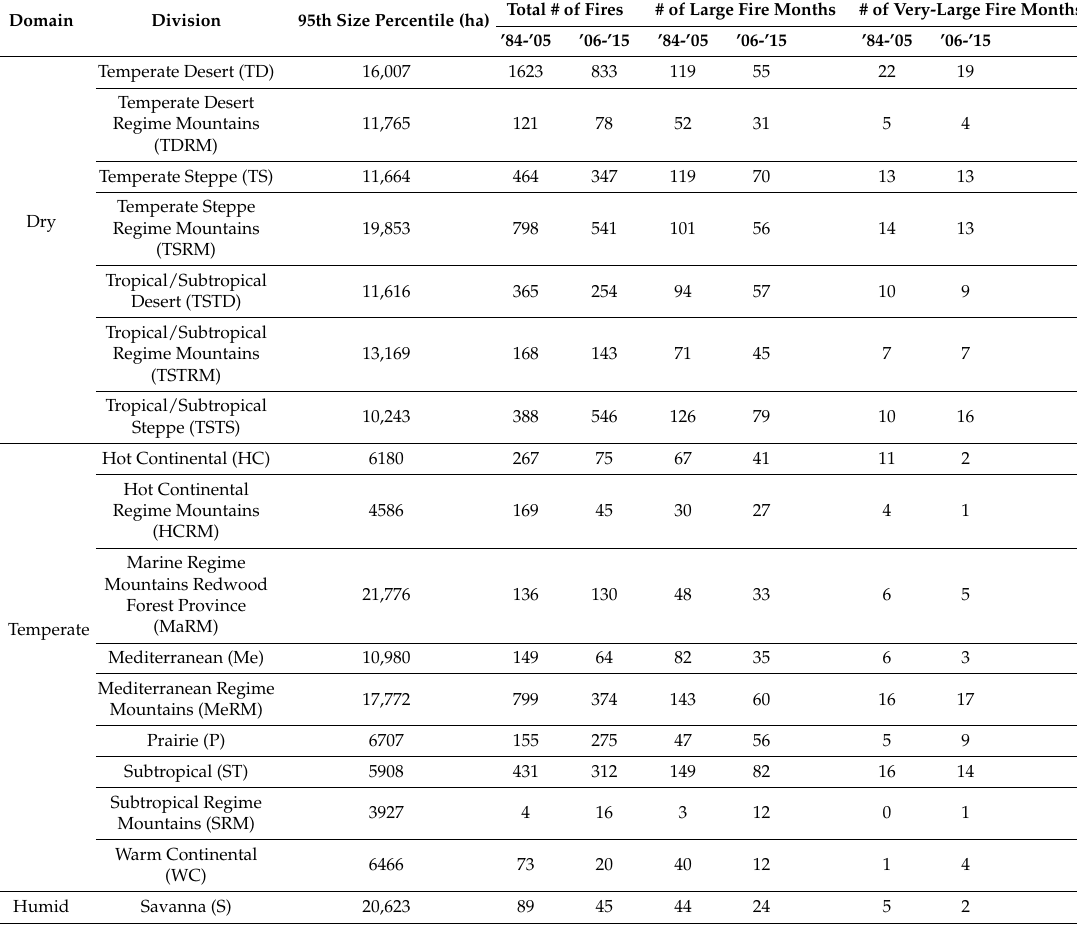
Table 1. Very-large fire cutoffs, the number of fires, large fire months, and very-large fire months